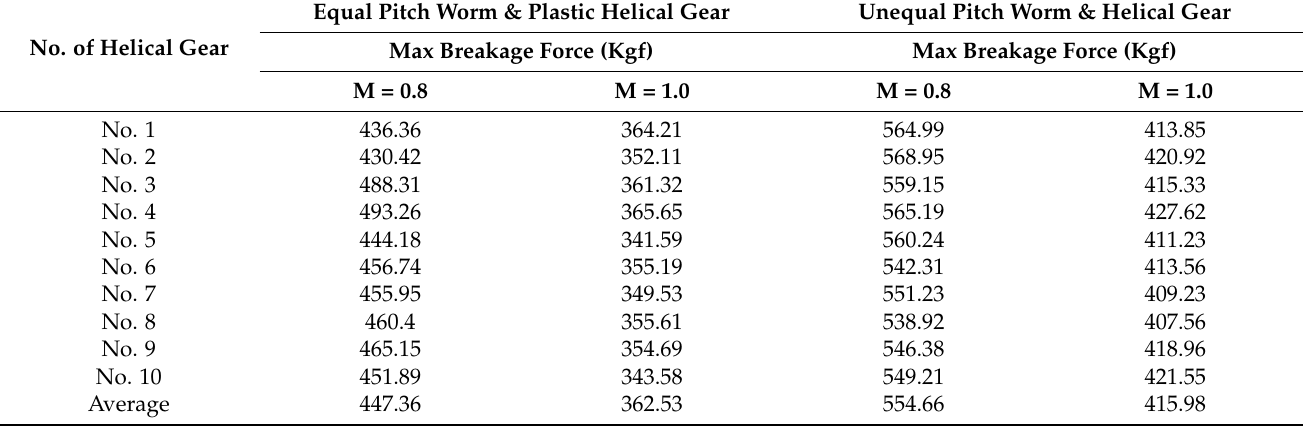
Table 5. Breakage test on the